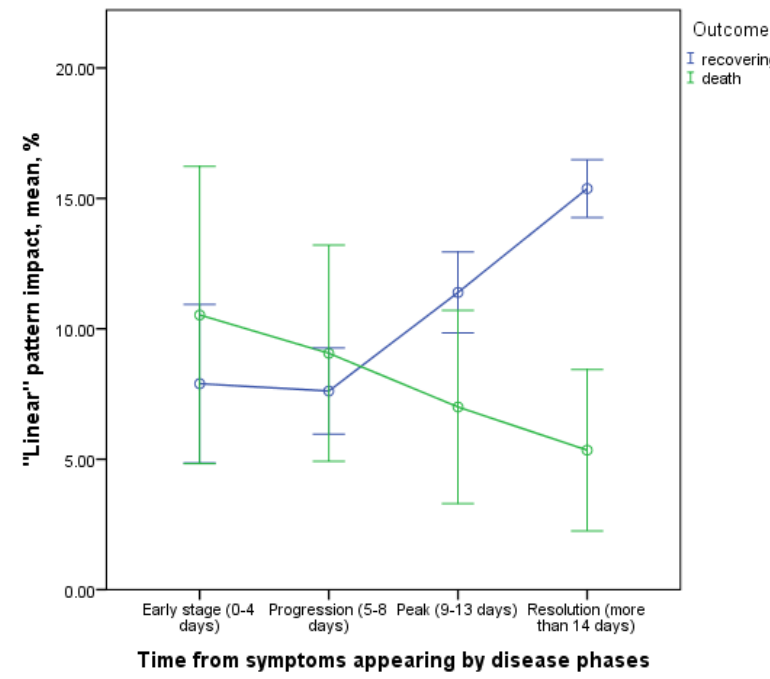
Figure 14. Contribution of linear bands to CT picture in the affected areas.